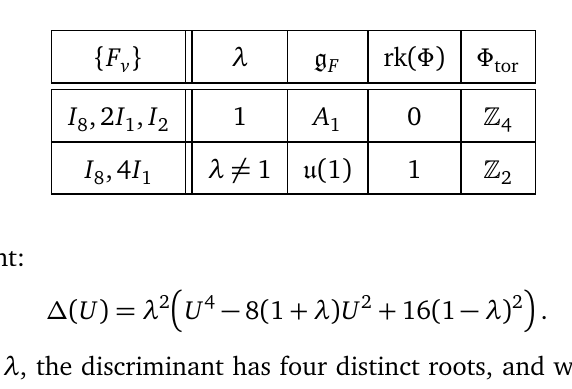
Figure 11: The U -plane of the D symmetry, which is enhanced to (cid:90) Table 10: The two configurations of singular fibers for the E